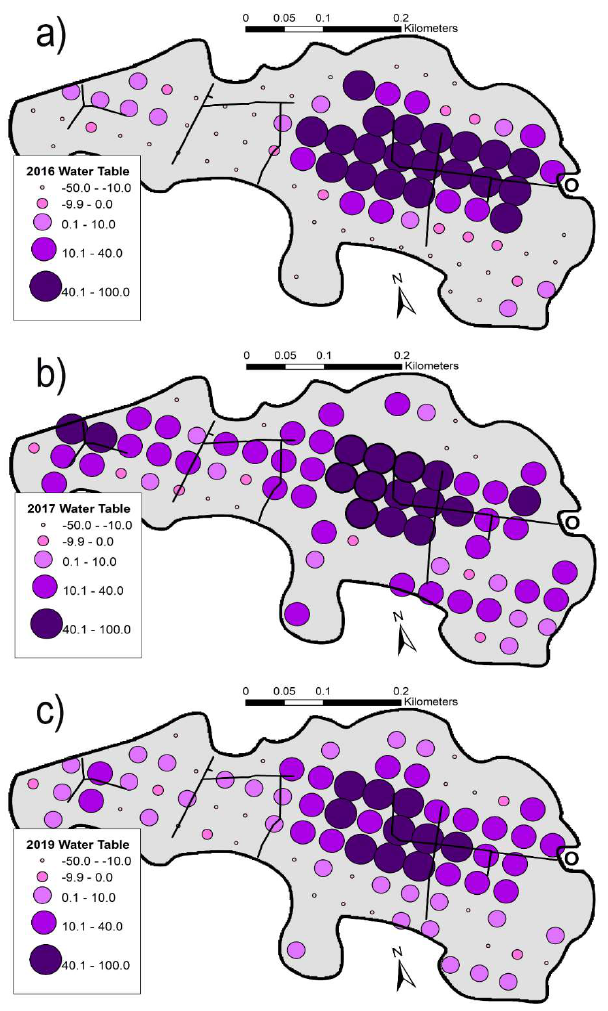
Figure 6. Distribution of water tables across Sandhill Wetland in ( a ) 2016, ( b ) 2017, ( c ) 2019. Water tables shown divided into five categories: −50.0–−10 cm below soil surface, −9.9–0.0 cm below soil surface, +0.1–+10.0 cm above soil surface, +10.1–+40.0 cm above soil surface, and +40.0–+100.0 cm above soil surface. Darker shades indicate wetter conditions. O = Outlet of Sandhill